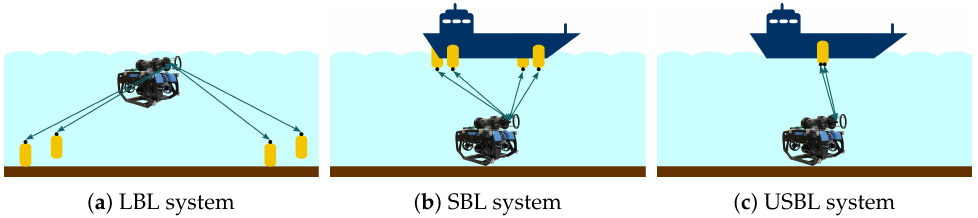
Figure 6. Acoustic underwater localization systems. The agent (in these figures a BlueROV2) carries a node to localize the agent with distance measurements to anchors (in yellow) at fixed positions. LBL: 50–2000 m between anchors. SBL: 20–50 m between anchors. USBL: single device. Abbreviations: long baseline (LBL), short baseline (SBL), ultra short baseline